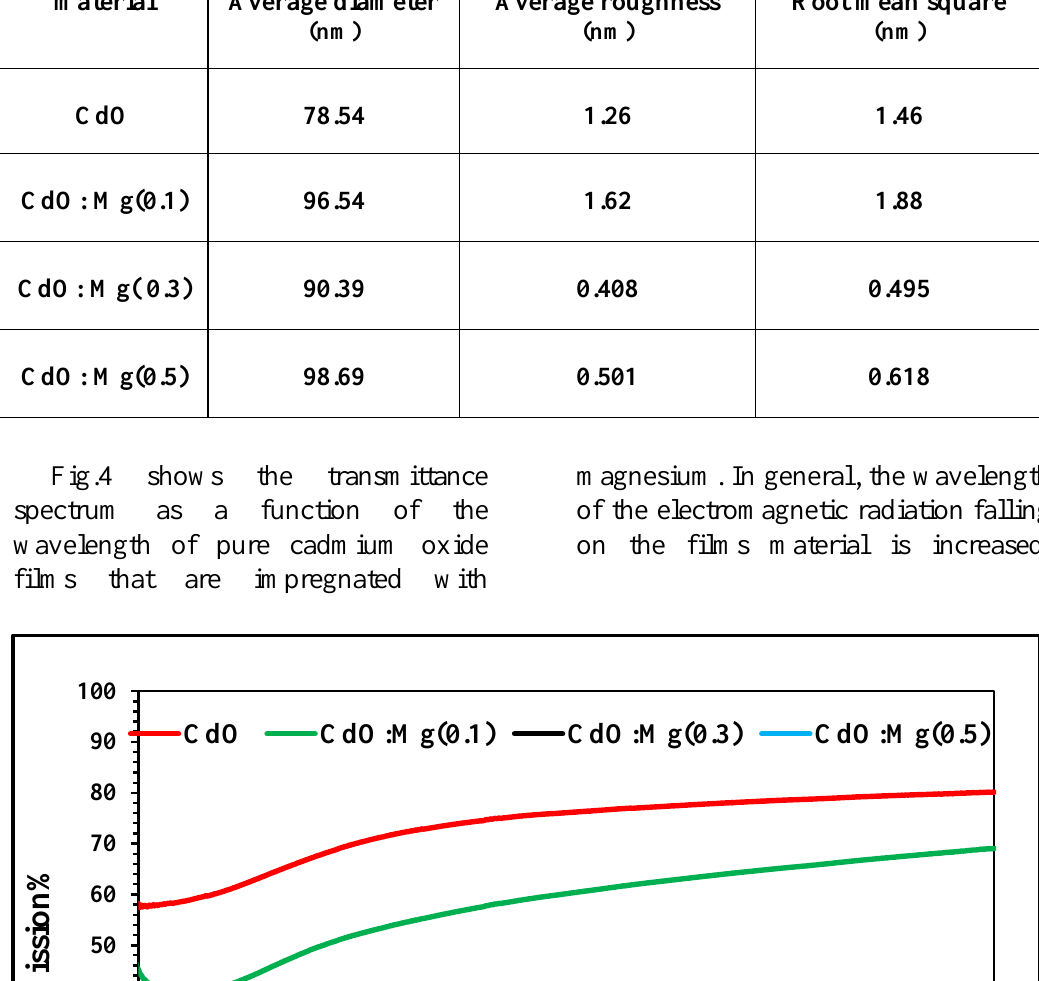
Table 2: Structural parameters of (CdO: Mg) membranes Obtained from the AFM examination. material